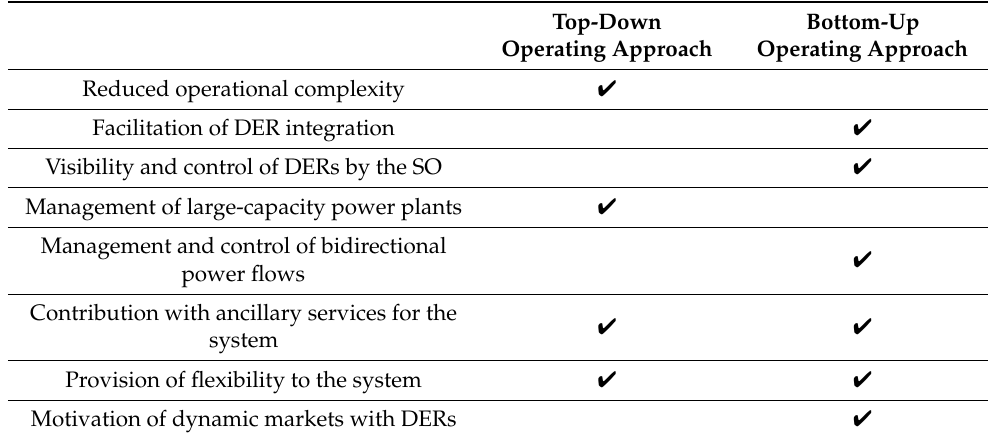
Table 3. Comparison between top-down and bottom-up operational approaches.